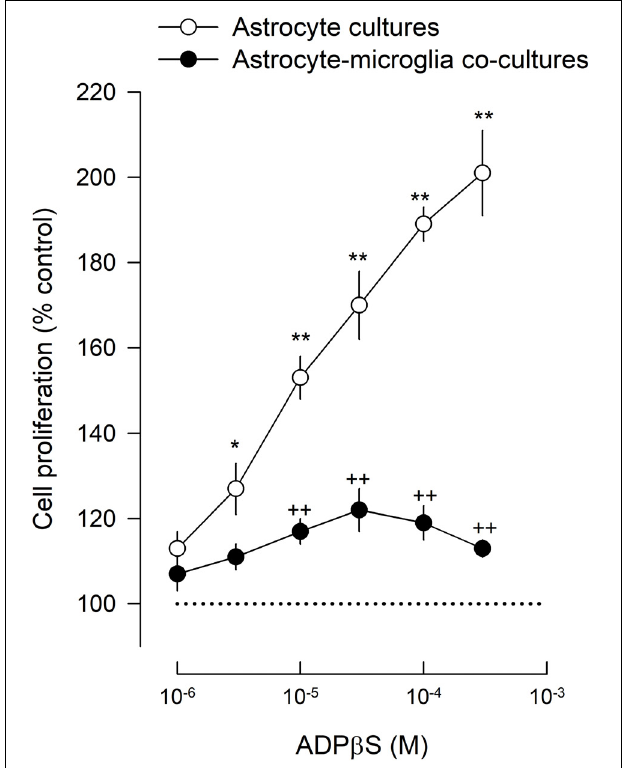
FIGURE 1 | Astroglial proliferation in astrocyte cultures and astrocyte-microglia co-cultures induced by ADP β S. Cultures were incubated with ADP β S or solvent for 48 h and methyl -[ 3 H]-thymidine (1 µ Ci/ml) was added in the last 24 h. Cell proliferation was estimated by methyl -[ 3 H]-thymidine incorporation and expressed in percentage of control. Values are means ± SEM from 4 different cultures. ∗ P < 0.05 and ∗∗ P < 0.01, significant differences from control (solvent). ++ P < 0.01, significant differences from the ADP β S in astrocyte